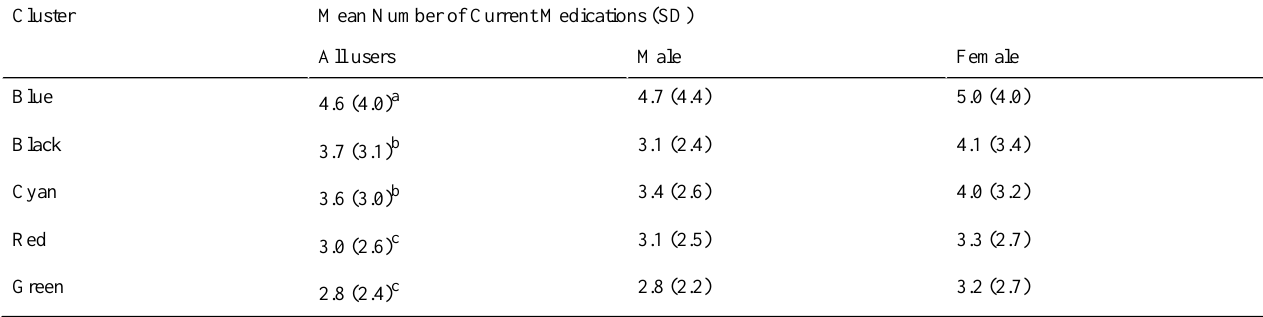
Table 4. Mean number of current mediations for males and females in each cluster. Mean Number of Current Medications (SD)Cluster